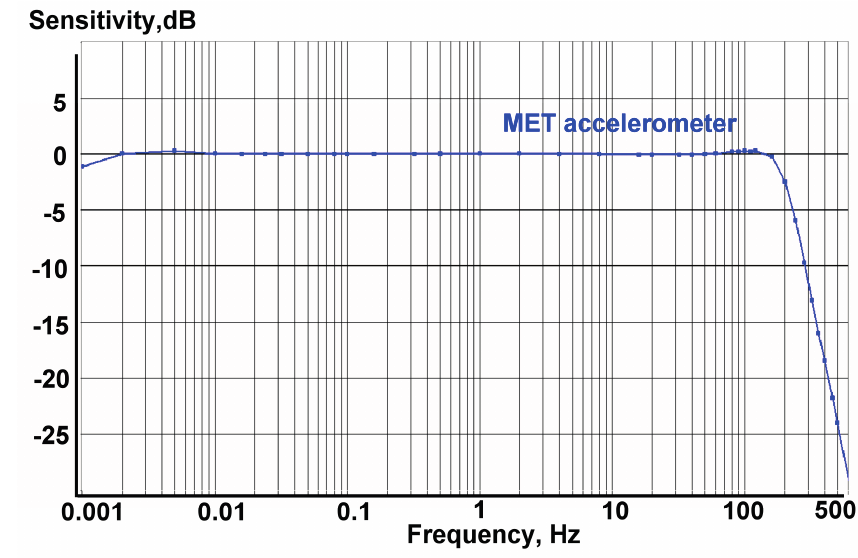
Figure 4. The extended low frequency MET sensor amplitude response. No output filters applied. 0 dB = 1 gV